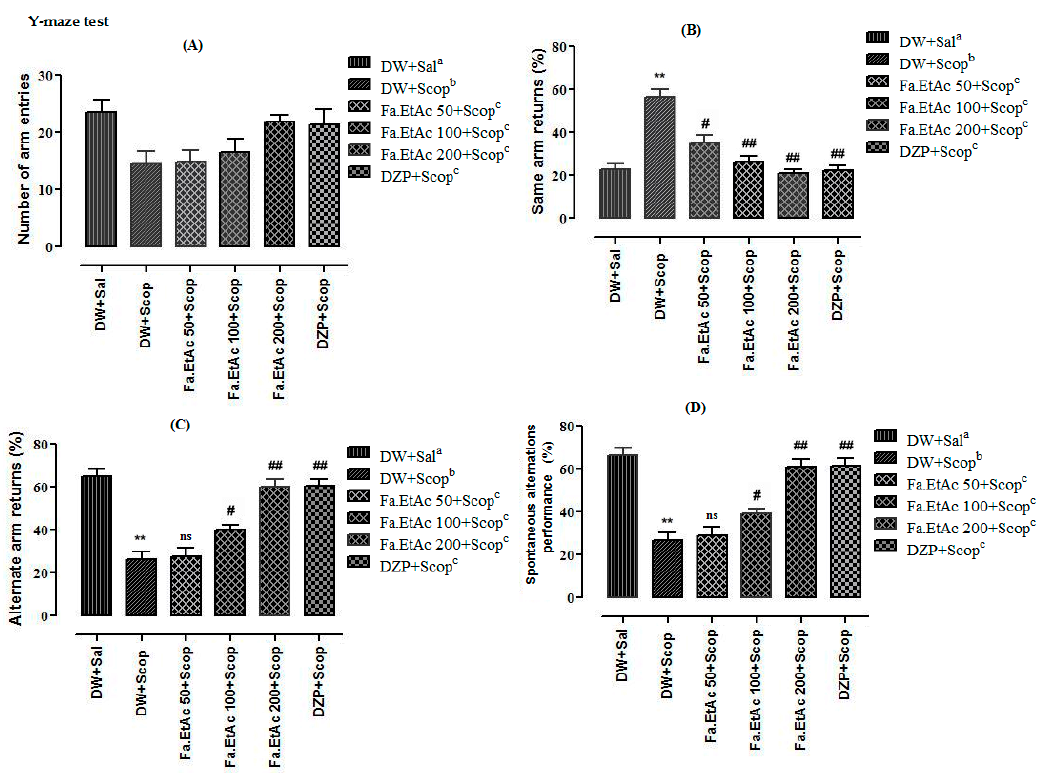
Figure 3. Effect of Fa.EtAc fraction of Ferula ammoniacum (D. Don) on mice in the behavioural Y-maze test. ( A ) Number of